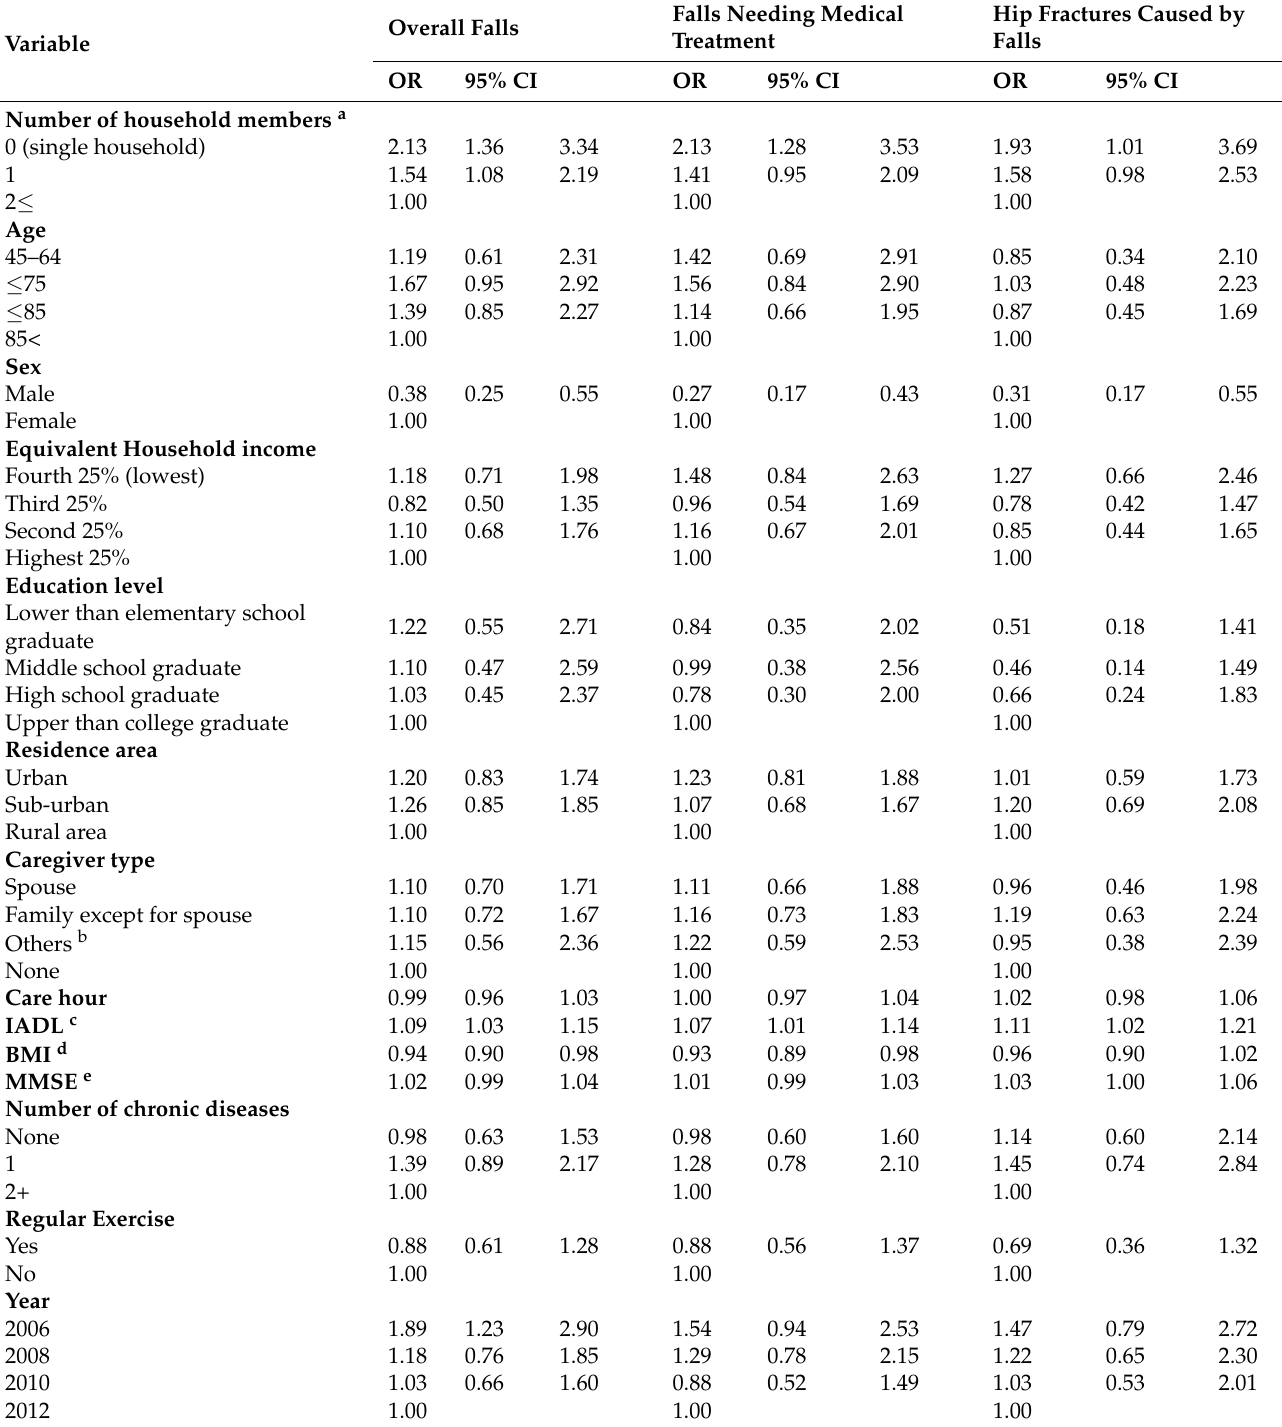
Table 2. Odds ratios for factors associated with overall falls, falls needing medical treatment, and hip fractures caused by